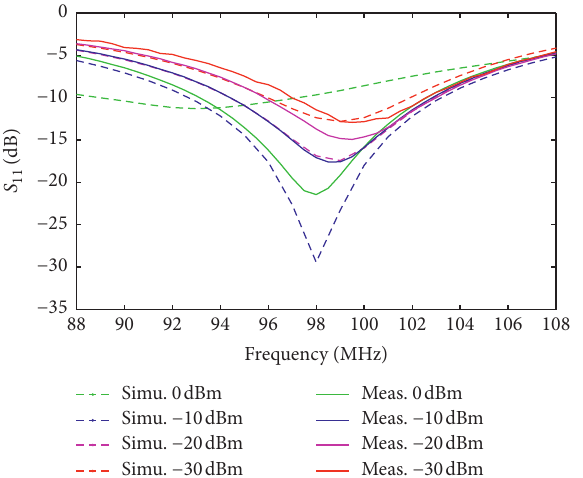
Figure 27: Simulated and measured S load.